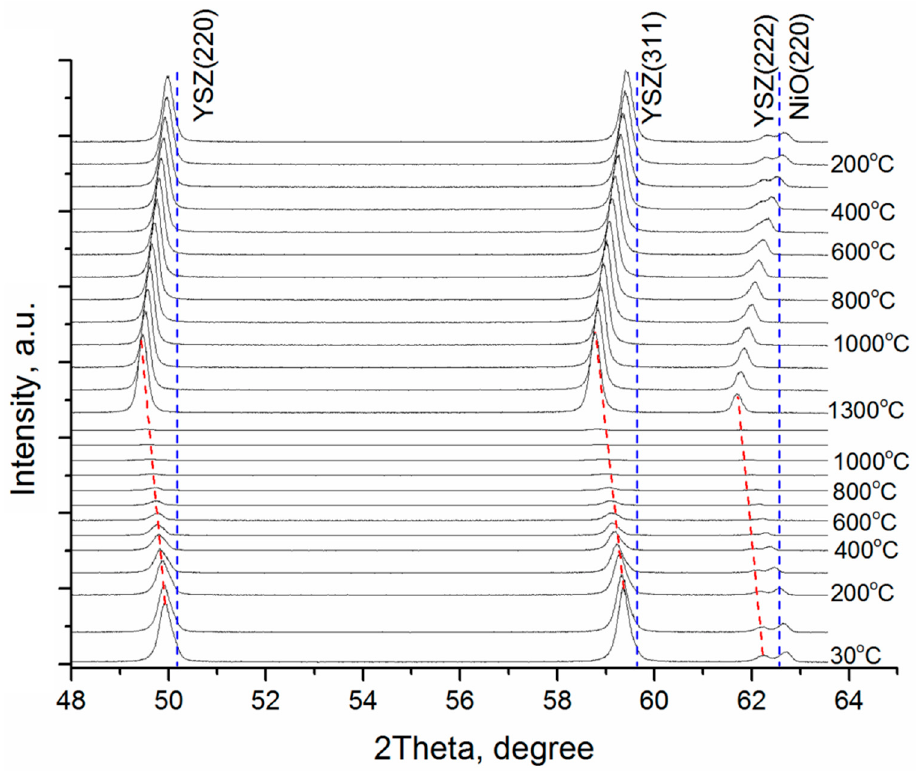
Figure 9. XRD patterns collected on the synchrotron beam line from YSZ film 2 after 1300 °C annealing in air and cooling to room temperature (8YSZ, PDF Card 04-001-9395 references are reported for comparison).